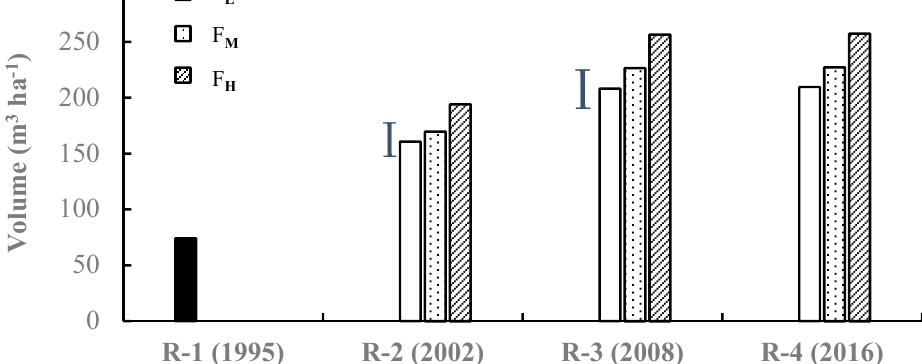
Figure 4. Wood production at harvests over four successive rotations of A. auriculiformis in relation to repeatedly applied site management practices; volumes in R-4 were projected to seven years. Numbers in brackets are years of planting. Vertical bars are LSDs at p < 0.05 for R-2 and R-3 .